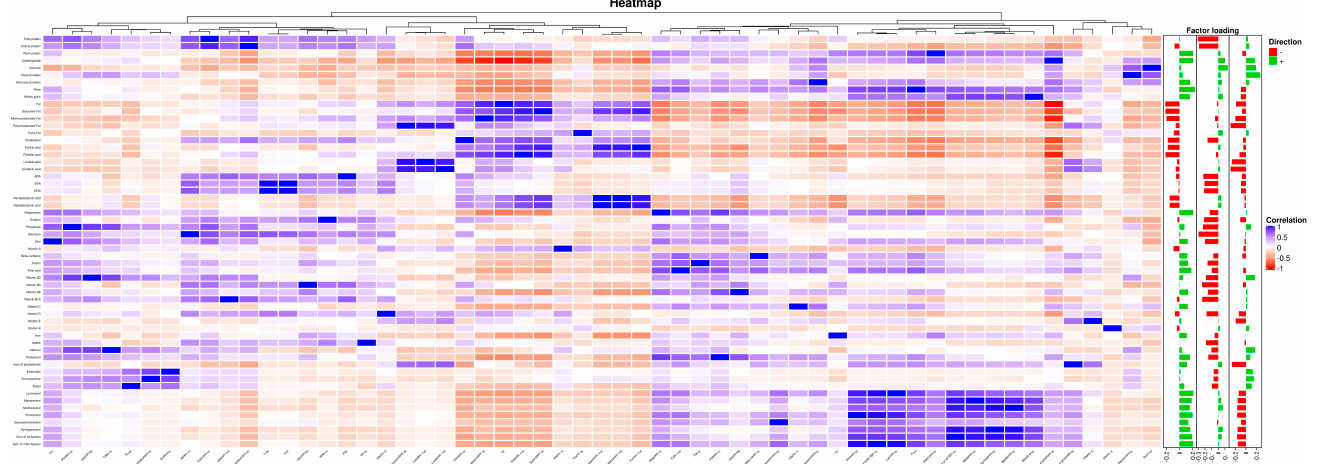
Figure 2. Heatmap of FFQ with 57 items and 3 PCA factor loadings. Correlation key: blue represents positive Pearson’s correlations and red represents negative Pearson’s correlations. Direction key: red represents a negative direction and green represents a positive direction, large loadings (bars) mean that a variable has greater effects on the principal